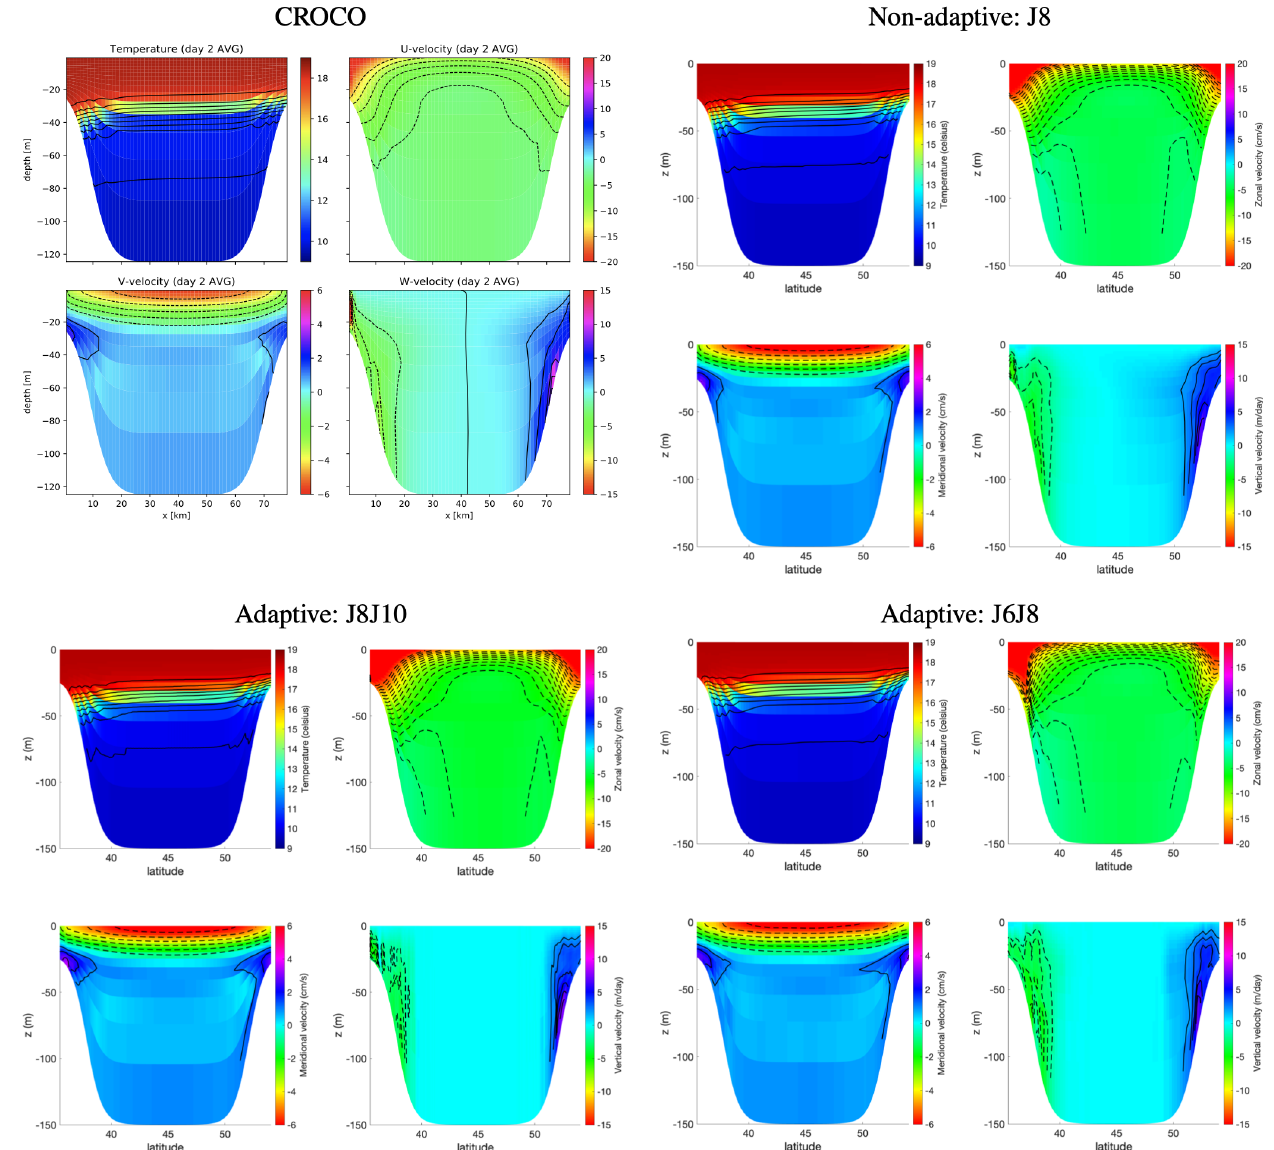
Figure 6. Results for the upwelling test case: zonal averages at day 2. Note that the CROCO results are for a β plane with zonal channel width of only 20km.